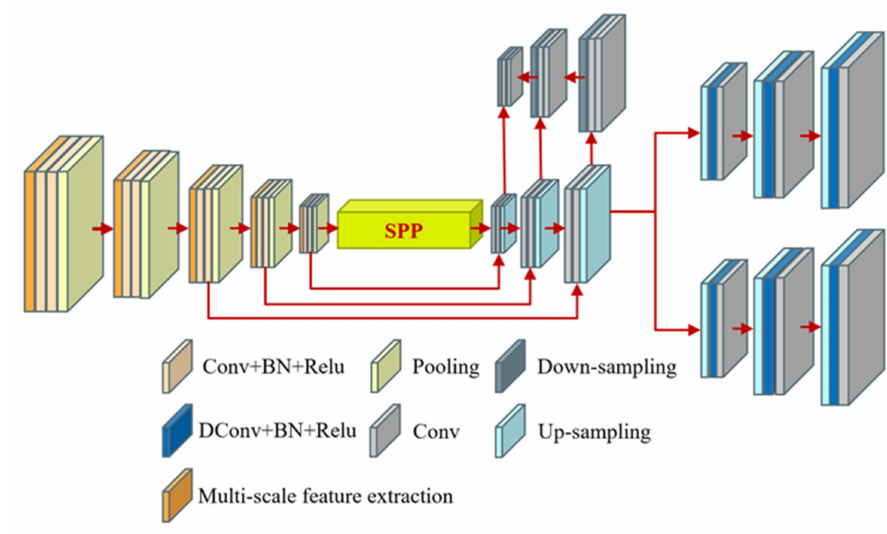
Figure 3. Building extraction module based on multitask